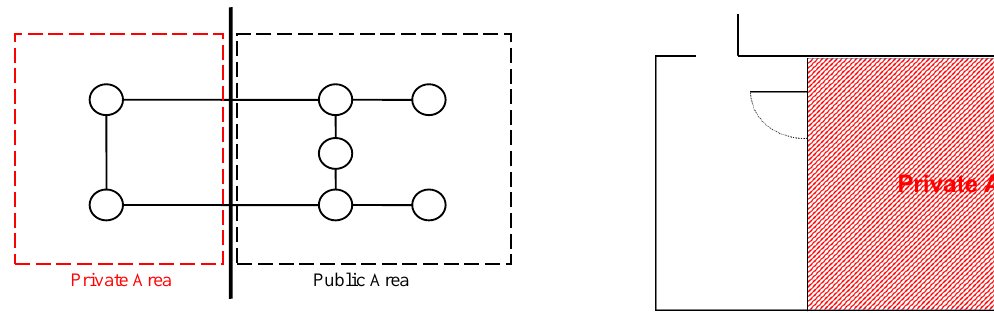
Performing a cut on a navigation graph to create a private and public